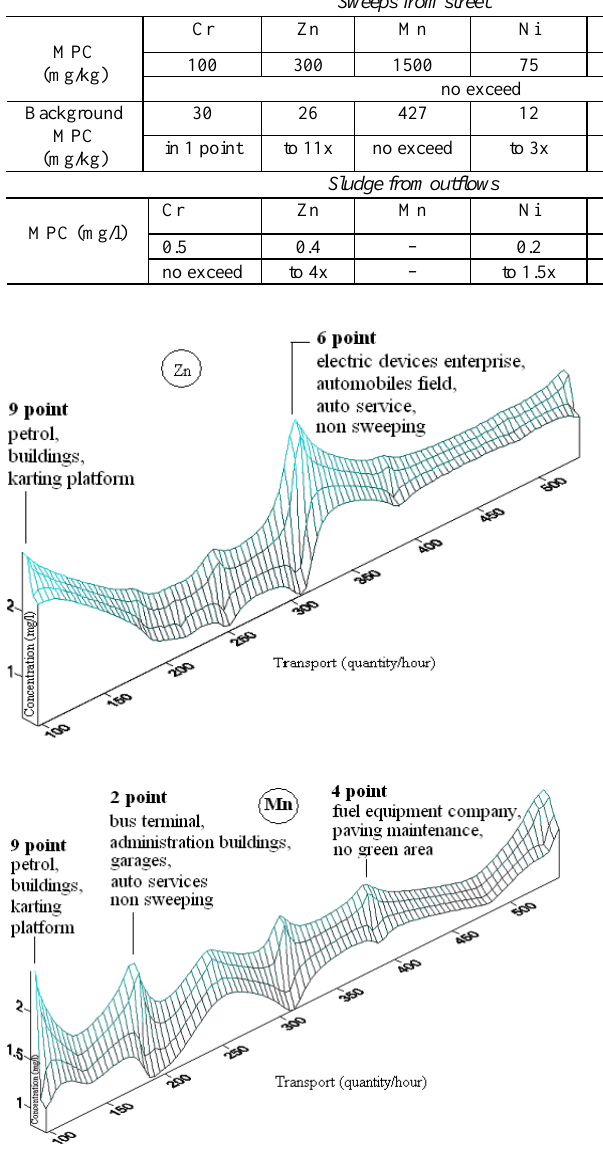
Fig. 4 . Common heavy metals concentration (mg/l) of sweeps